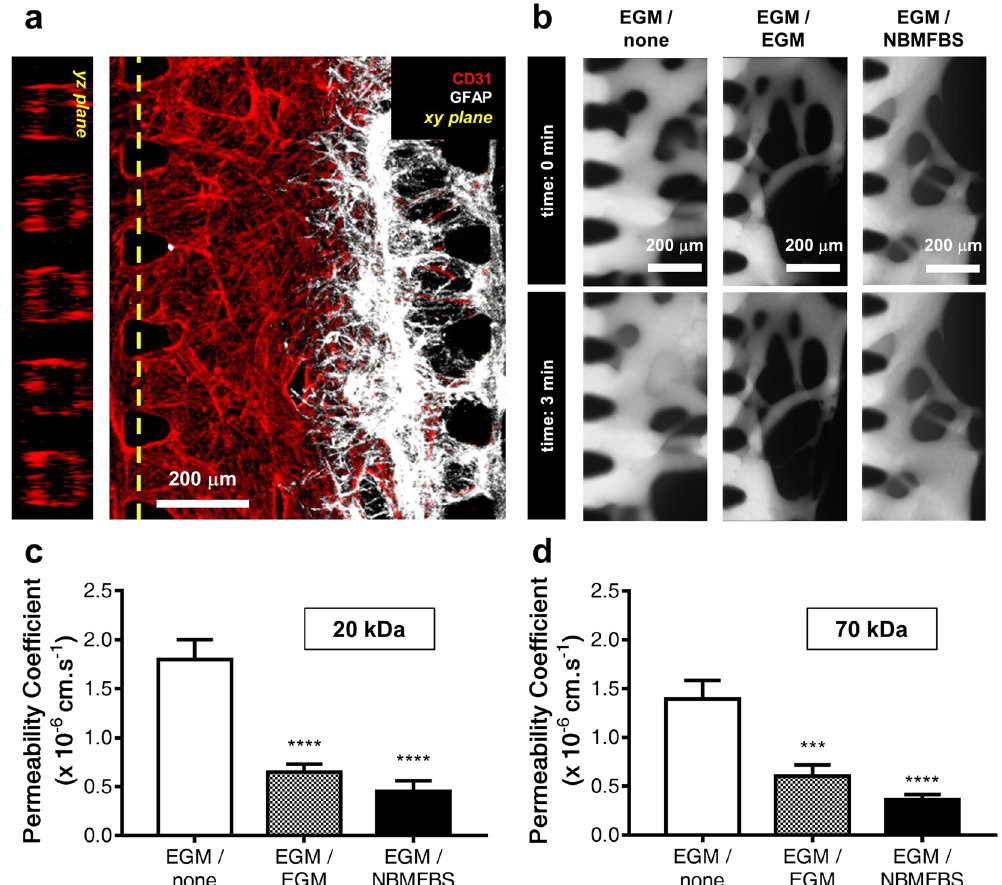
Figure 5. Vascular network - astrocyte complex permeability compared across the three experimental co-culture medium compositions. ( a ) Immunostained imaging of the vascular network and the astrocytic interface confirms that vascular lumens cover all of the areas between VC side microposts. This means that any substances introduced through the VC into the vascular network can be assumed to be flowing inside the vascular network and not in the fibrin hydrogel. ( b ) Time-lapse microscopic photographs at various medium conditions with 70 kDa FITC-dextran. ( c ) Results of permeability experiments with 20 kDa FITC-dextran. ( d ) Results of permeability experiments with 70 kDa FITC-dextran. All data show mean ± SEM. Statistical analysis student’s t-test. *** p < 0.001, **** p <